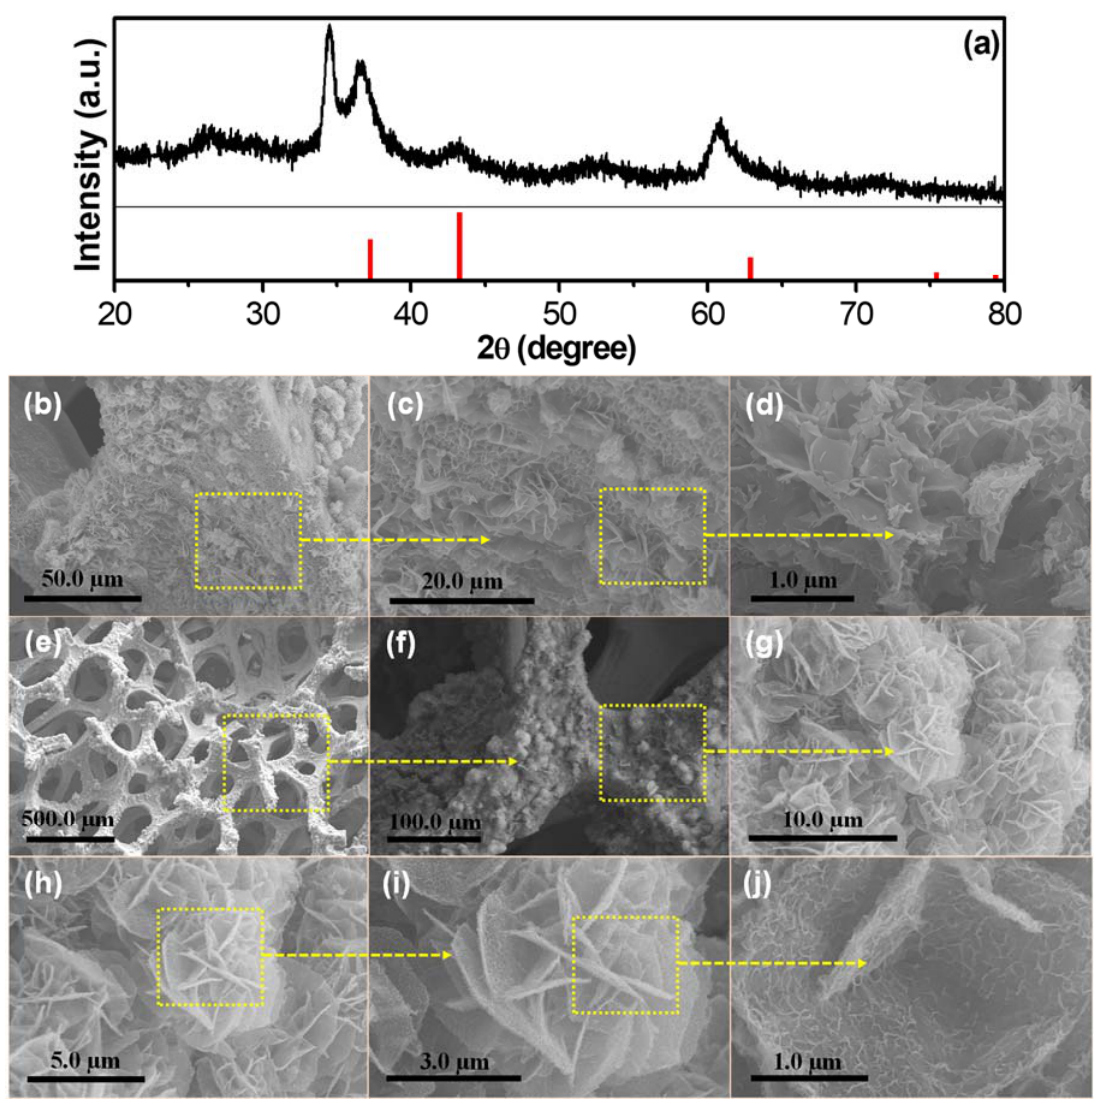
Figure 2. ( a ) XRD patterns of NiZn 2 O 4 @3D ‐ NF, and FE ‐ SEM images of ( a – c ) nickel oxide, and ( d – j ) NiZn 2 O 4 @3D ‐ NF at different magnifications.